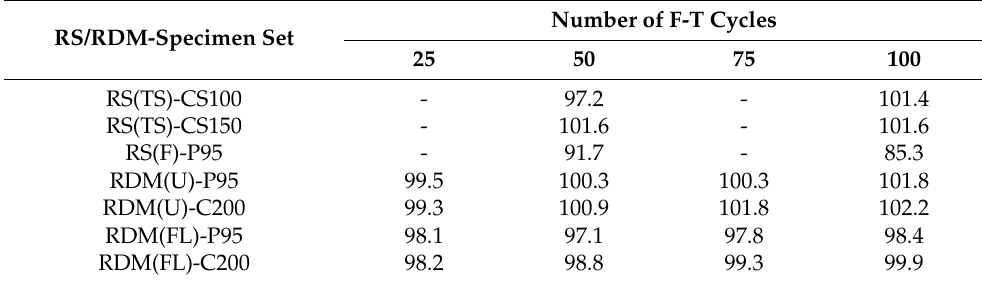
Table 3. Relative development of the monitored strengths and moduli of elasticity of concrete in relation to the number of F-T cycles in